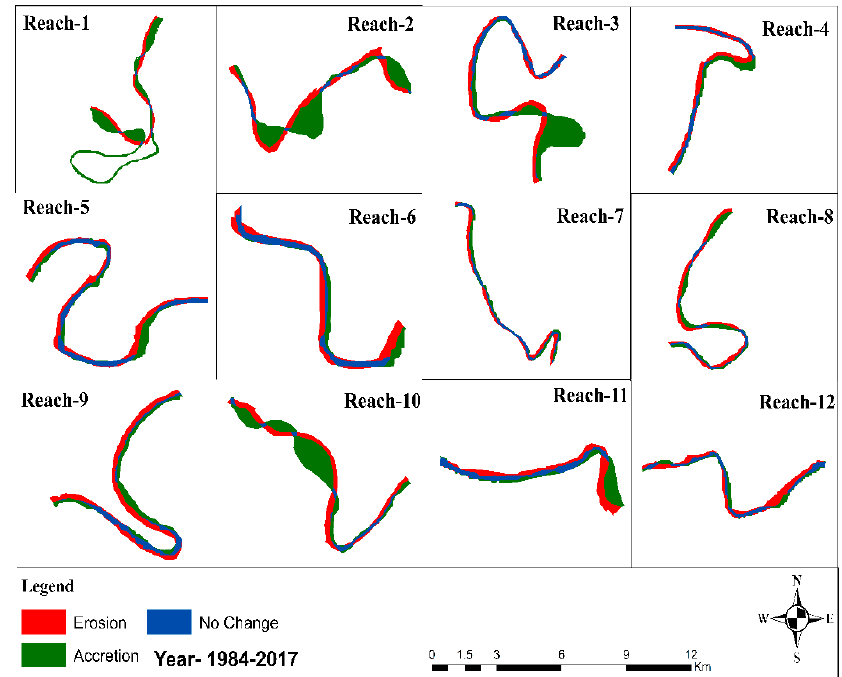
Figure 13. Map of erosion, accretion, and unchanged area between 1984–2017.